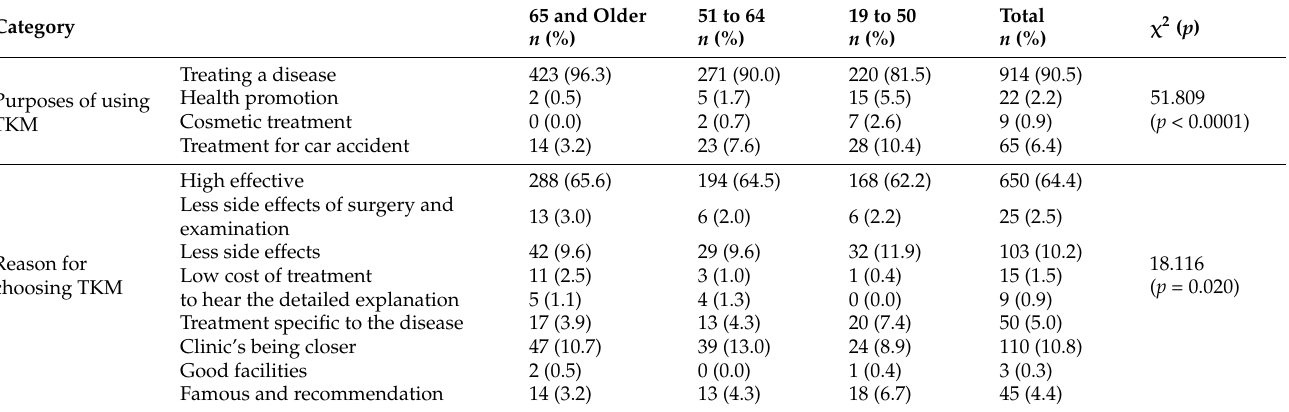
Table 2. Purpose of using TKM and reasons for choosing TKM over traditional